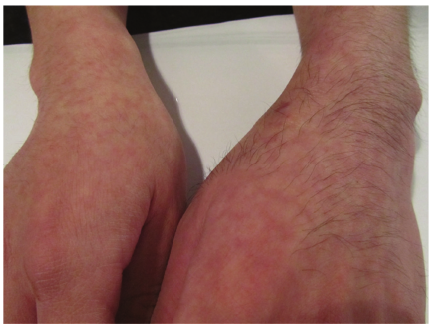
Figure 1: Hypertrichosis of the left forearm and hand following the application of a